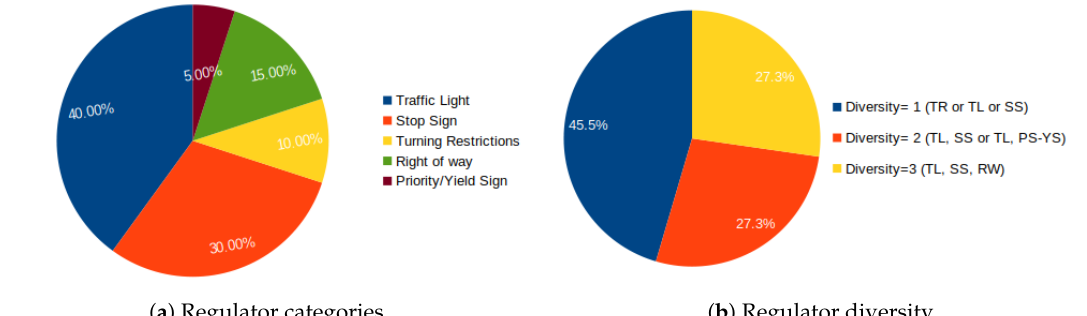
Figure 6. Regulator categories and diversity across SLR reviewed studies.